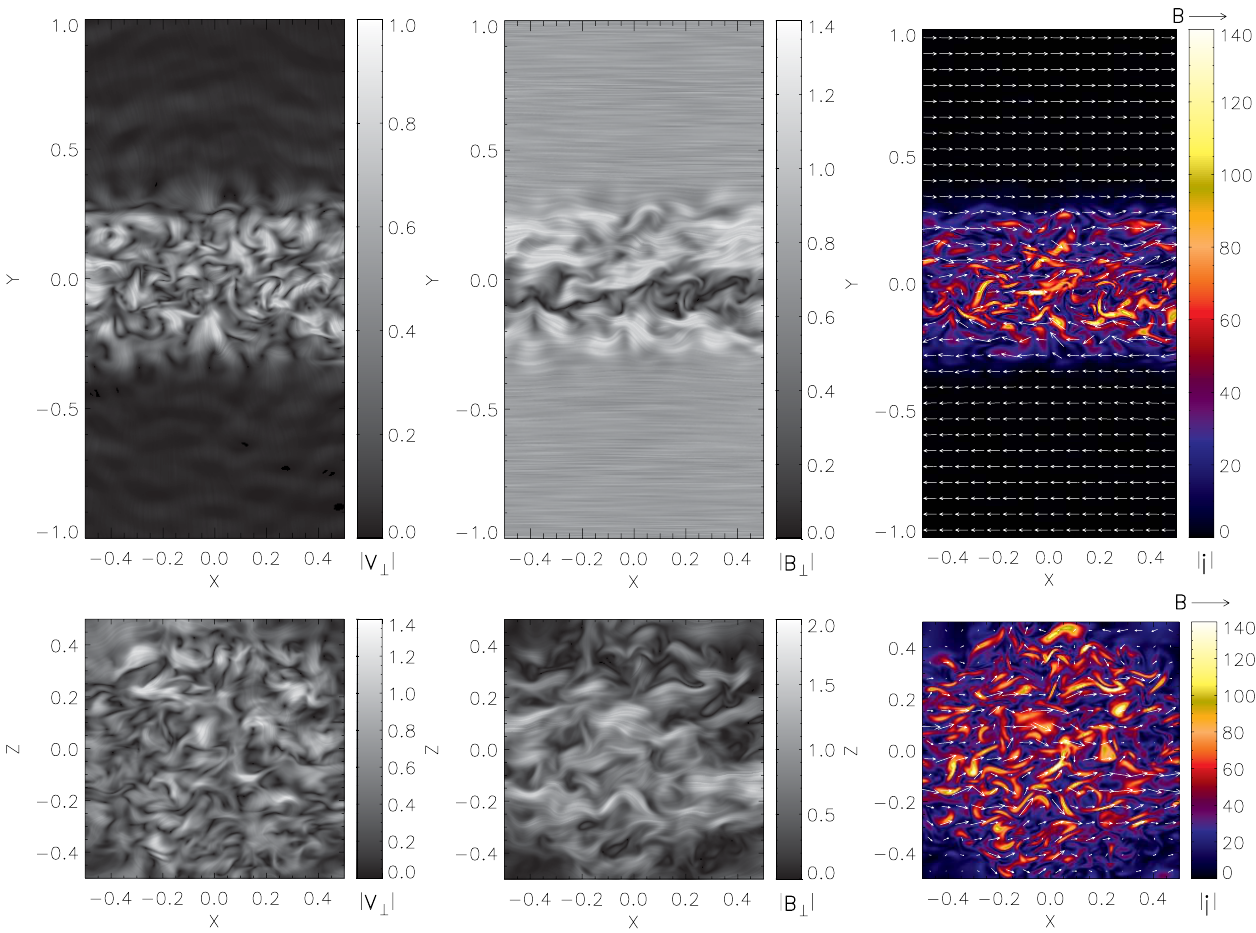
Fig. 5. Topology and strength of the velocity field (left panel) and magnetic field (middle panel) in the presence of fully developed turbulence for an example model with old driving at time t = 12. In the right panel, we show distribution of the absolute value of current density | J | overlapped with the magnetic vectors. The images show the XY-cut (upper row) and XZ-cut (lower row) of the domain at the midplane of the computational box. Turbulence is injected with power P inj = 1 at scale k inj = 8 into velocity. Magnetic field reversals observed are due to magnetic reconnection rather than driving of turbulence, which is